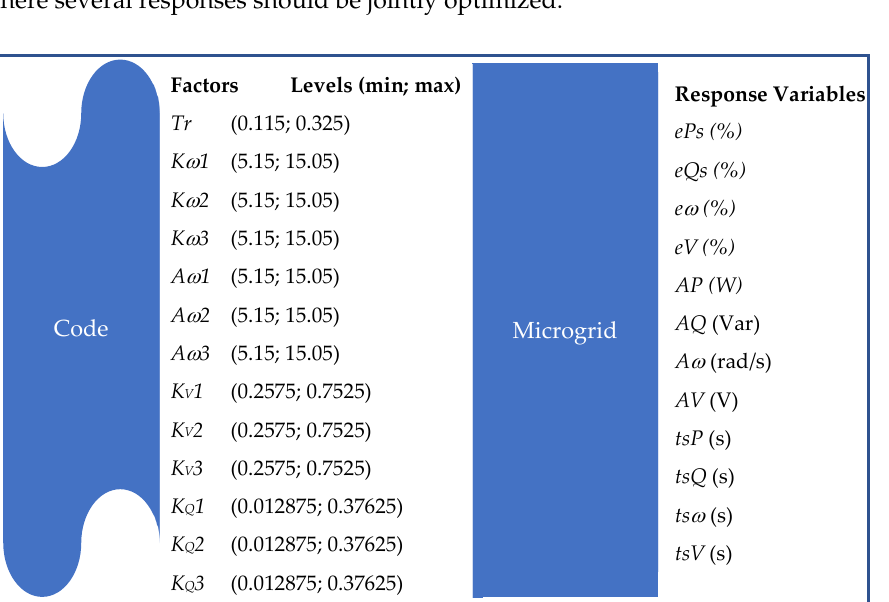
Figure 5. Software scheme to help select appropriate designs.